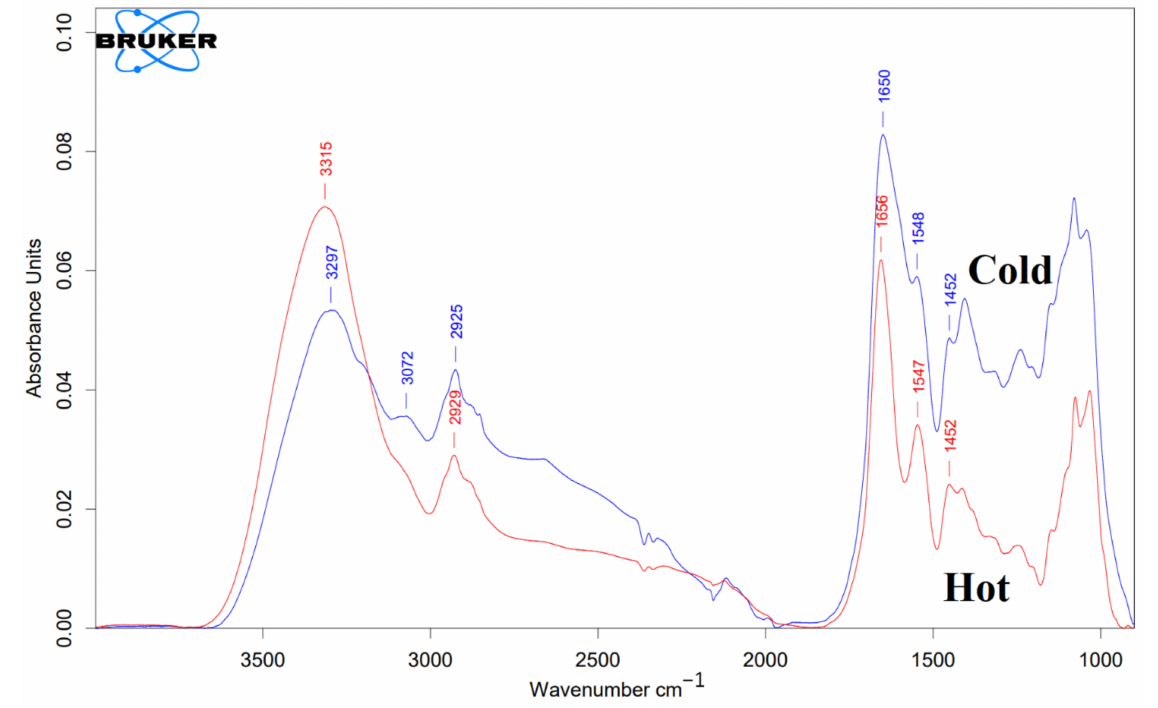
Figure 5. FTIR characterization of both “cold” and “hot” AuNPs. The blue line represents “cold” AuNPs, and the red line represents “hot” AuNPs. As mentioned in the text, on the surface of the control AuNPs (without protein corona), there are peptides or proteins that act as capping